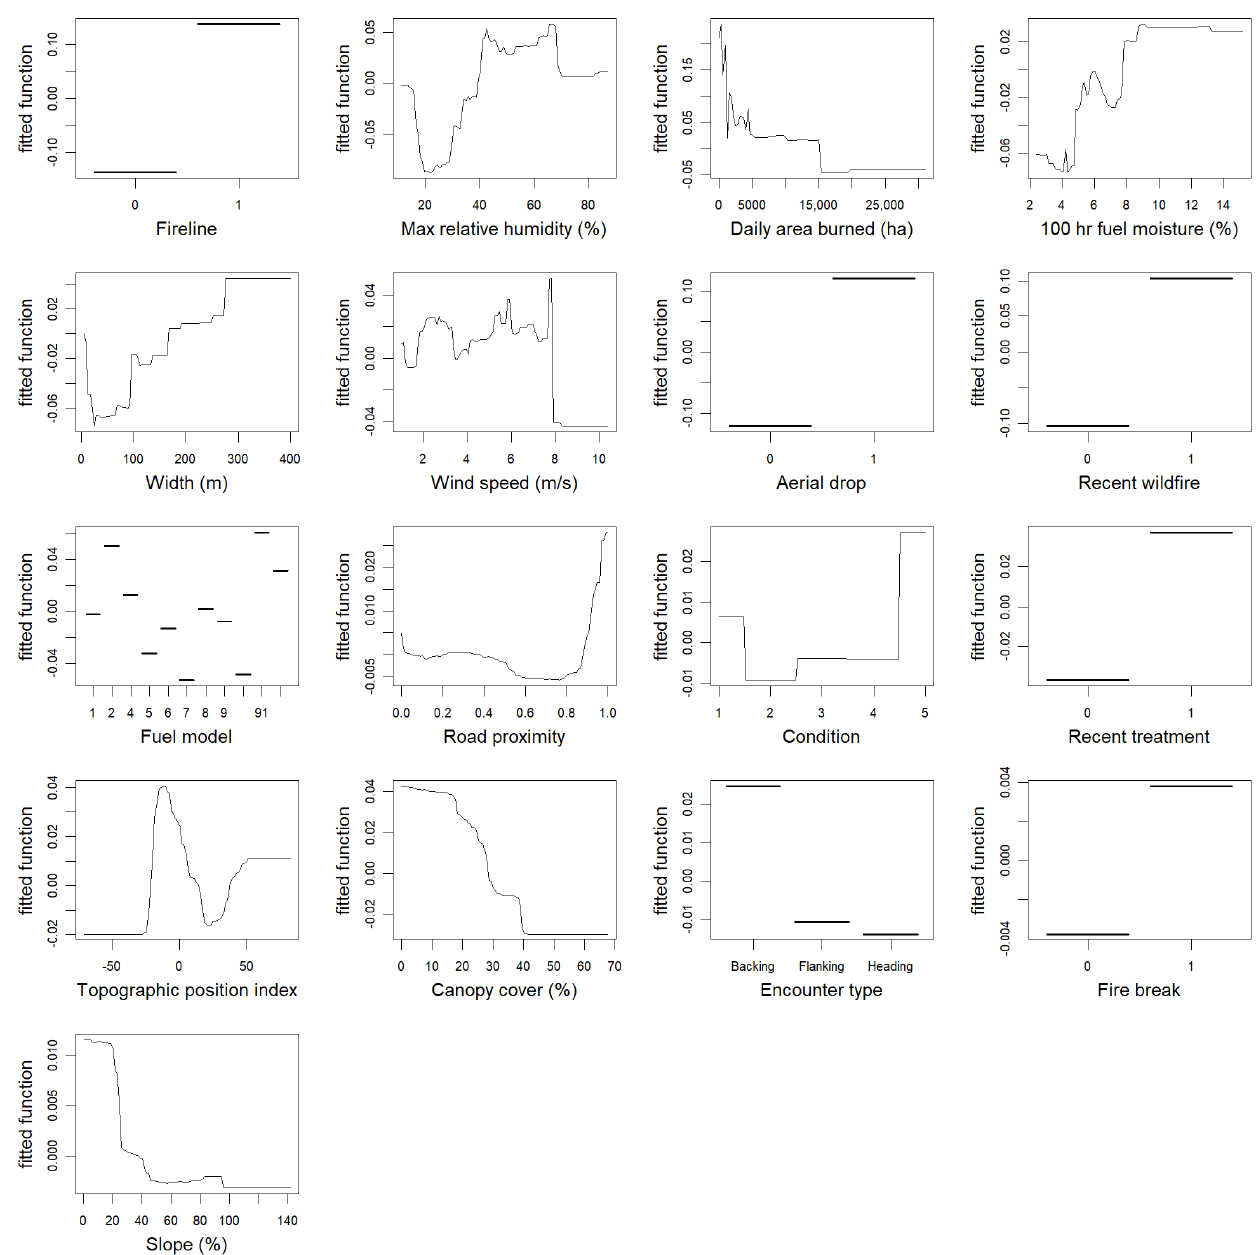
Figure 4. Partial dependence plots for Model 2 with the full training data showing the mean effect of each variable, sorted in order of descending relative variable importance.